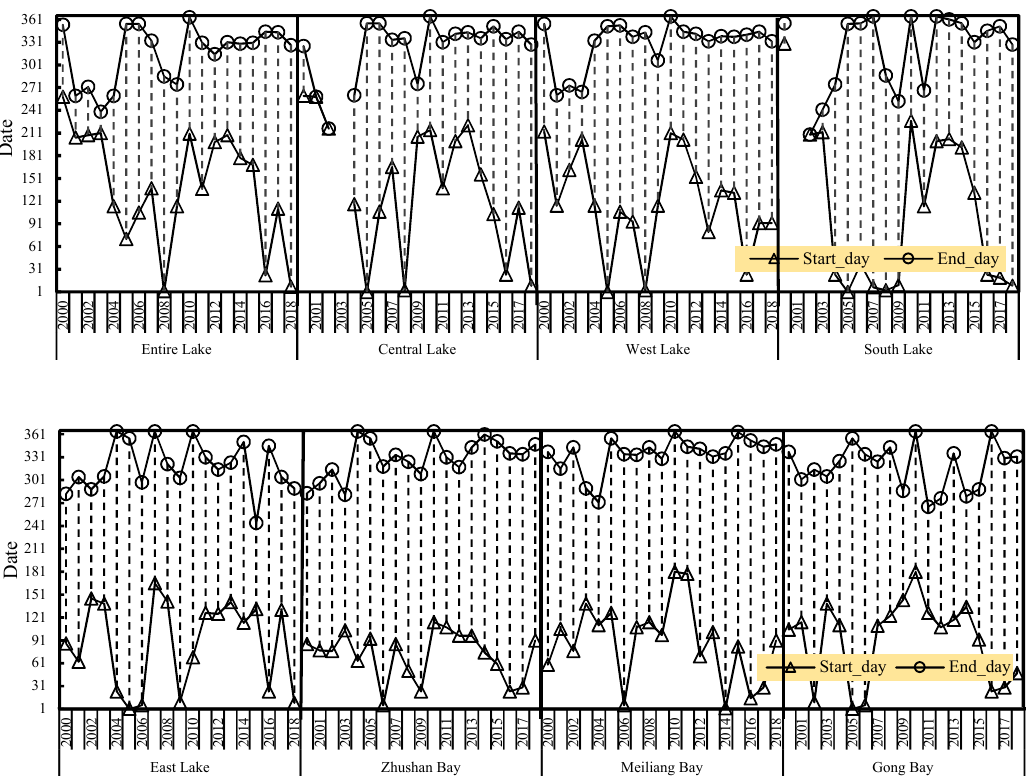
Figure 14. Timing and duration of significant cyanobacteria blooms for the entire lake (excluding East Bay) and each segment.